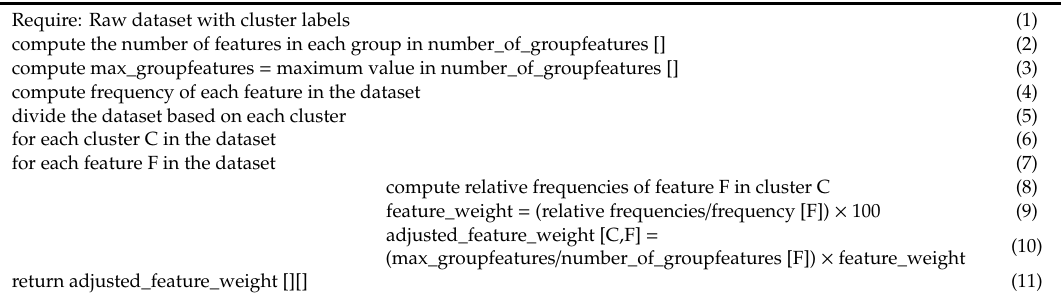
Table 1. Showing how the size of the rectangle is computed in the hierarchical